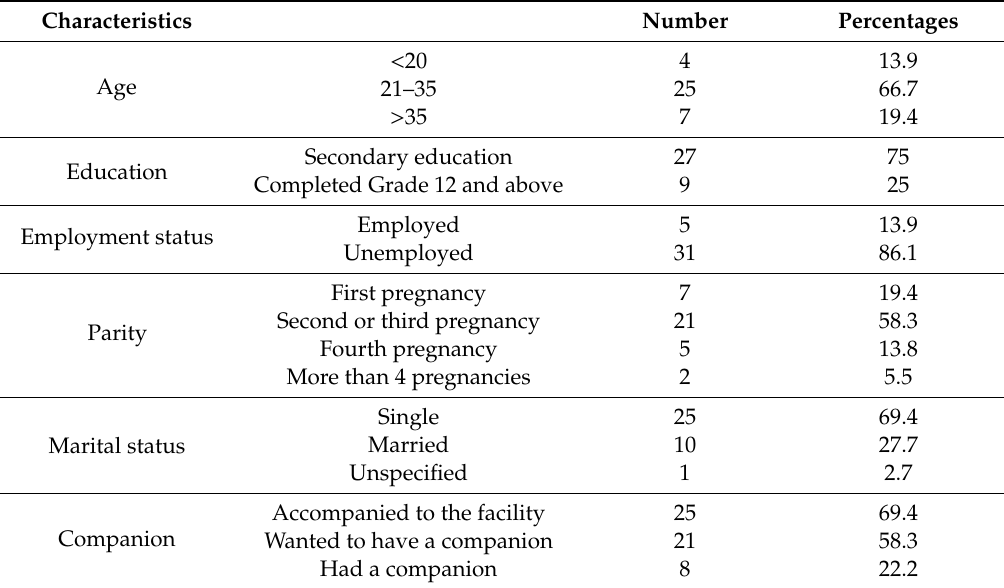
Table 2. Sociodemographic characteristics of the